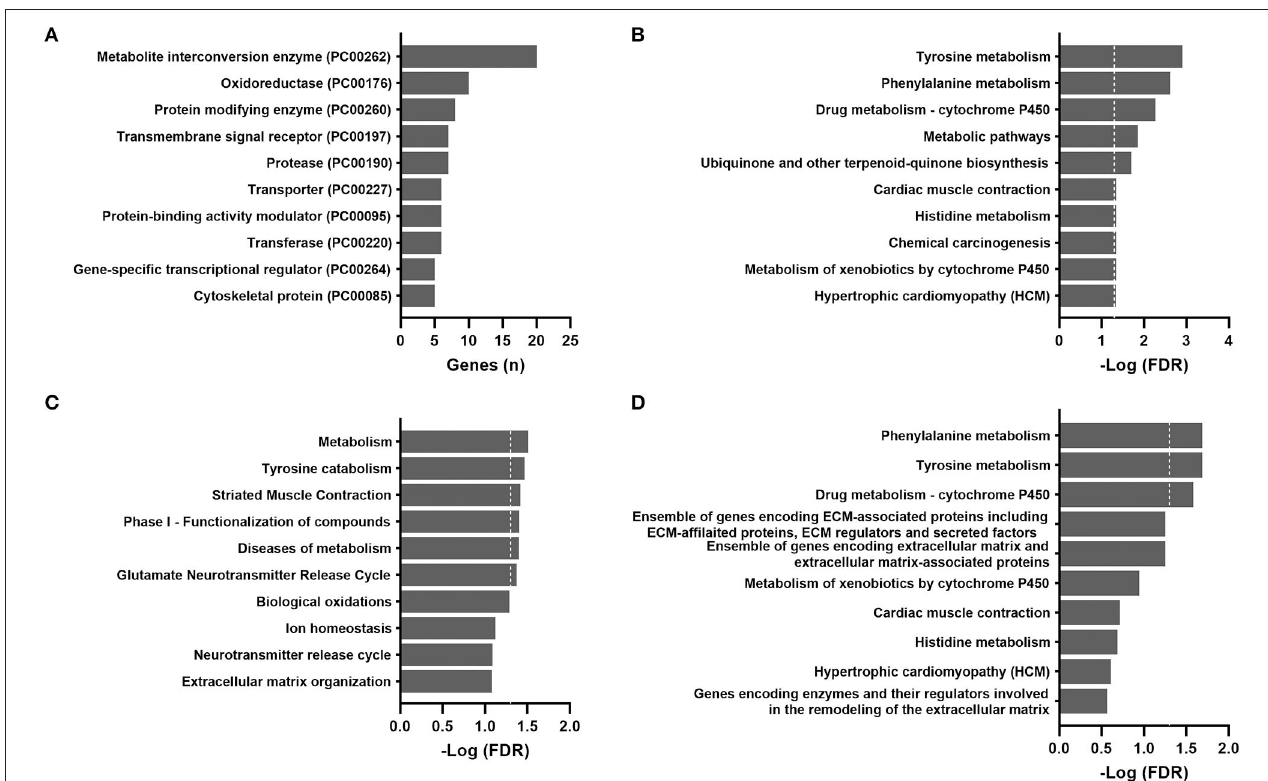
FIGURE 2 | Over-representation pathway analysis of aging-correlated genes in the TCGA THCA dataset: (A) PANTHER protein class, (B) KEGG, (C) Reactome, and (D) BioCarta. The top 10 classes or pathways are listed. Values above the dashed line represent significant enrichment (5% level of significance). FDR, false discovery